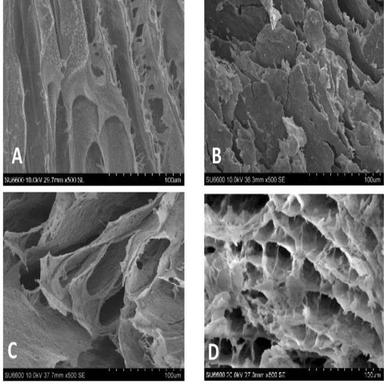
SEM micrographs – PR24.